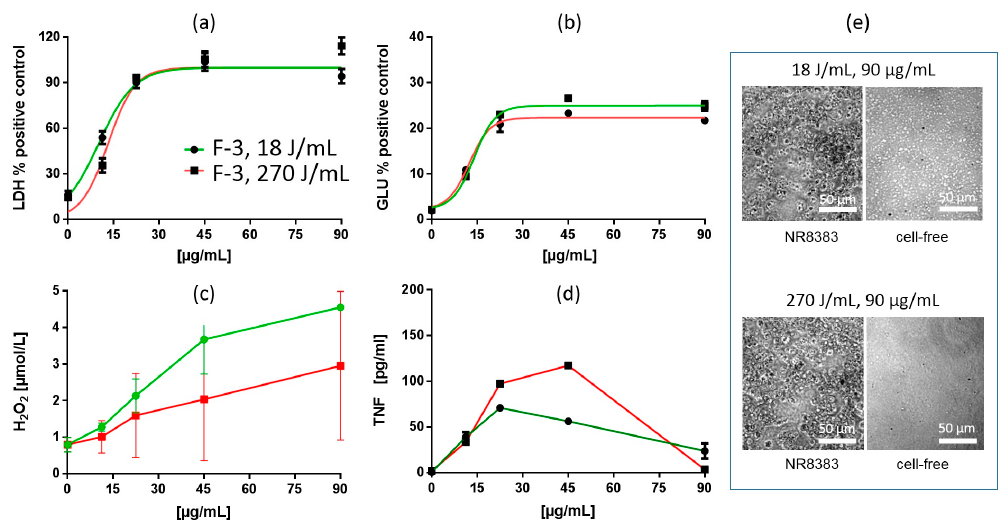
Figure 6. In vitro response of NR8383 alveolar macrophages to fumed silica F-3. Particles were dispersed with either 18 J/mL (green) or 270 J/mL (red). ( a ) lactate dehydrogenase activity (LDH), ( b ) glucuronidase activity (GLU), ( c ) H 2 O 2 concentration, and ( d ) tumor necrosis factor alpha (TNF). ( e ) NR8383 cells after 16 h exposure to P-5, dispersed with 18 J/mL or 270 J/mL; right panels show particles settled onto the bottom of culture well under cell-free conditions. Note that F-3 granules appear smaller at 270 J/ml and that cells treated with both qualities appeared deteriorated.